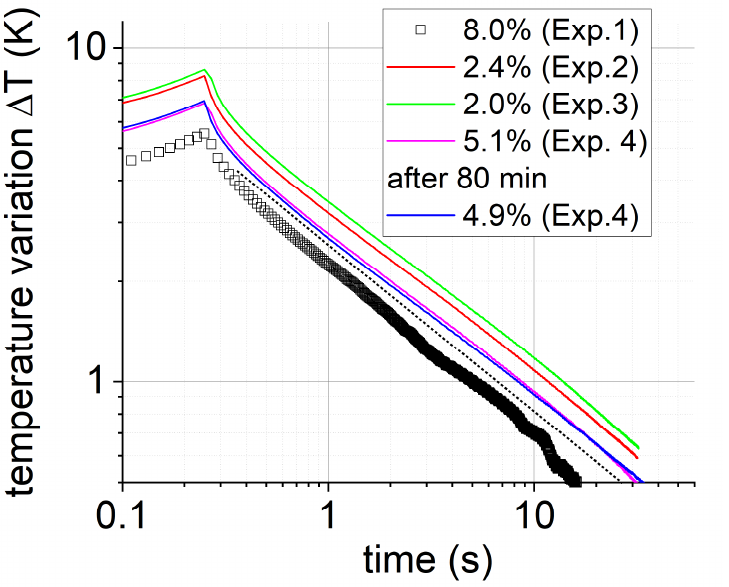
Figure 19. Surface temperature transients recorded in the type 1 sample (formwork side) in different trials with different moisture contents. The dotted line represents a curve according to Equation (1).